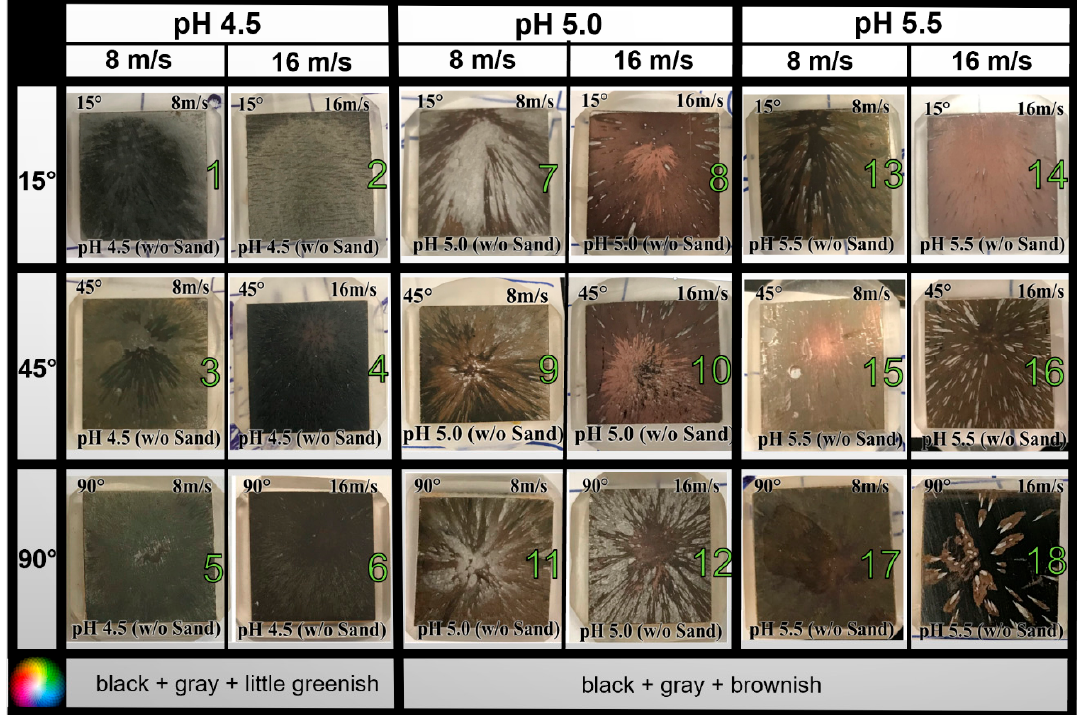
Figure 3. Pictures of API 5L X65 specimens after testing in CO 2 flow accelerated corrosion (FAC) at three pH levels (4.5, 5.0, 5.5), three angles (15°, 45°, 90°), two velocities (8, 16 m/s), and at room temperature.